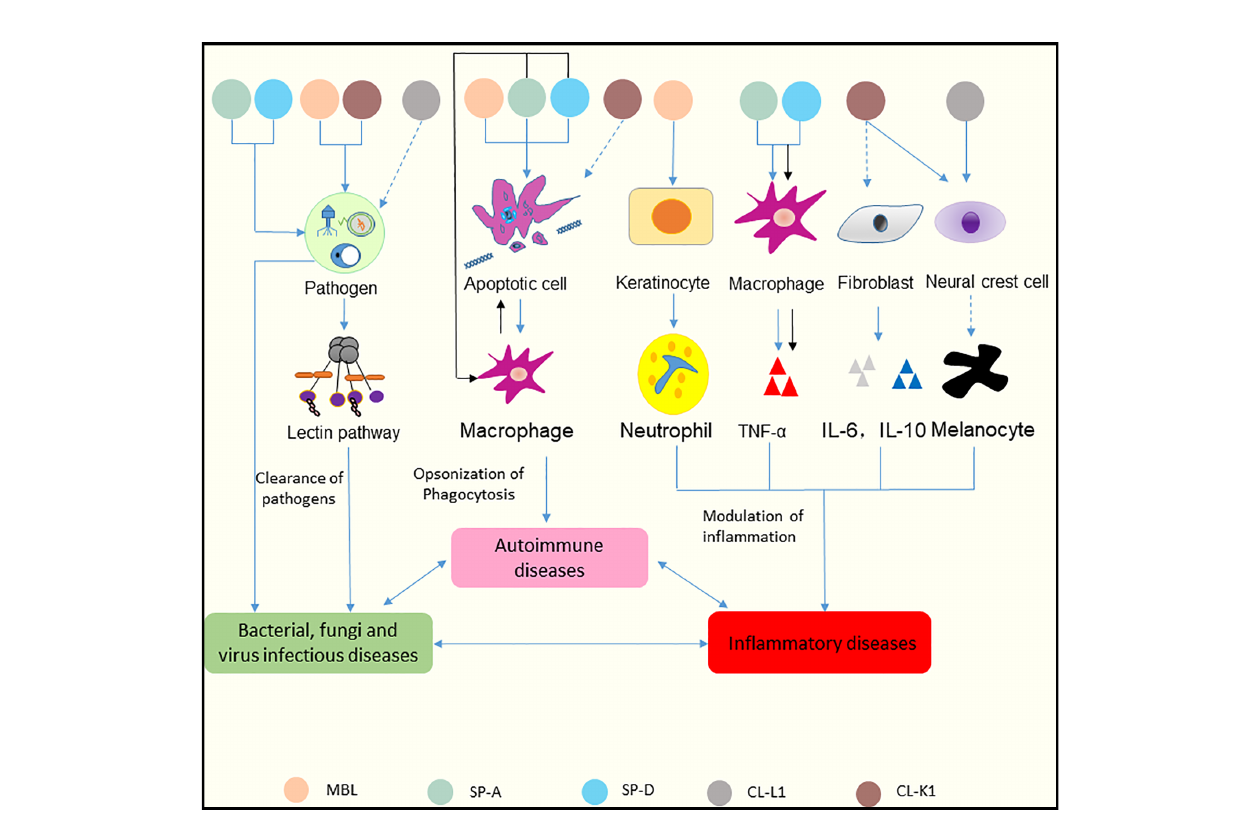
FIGURE 4 | Functions of collectins in skin immune homeostasis. Collectins are similar in structure in terms of their carbohydrate recognition domains, collagen-like, and N-terminal regions. MBL and CL-K1 recognize microorganisms and activate the lectin pathway to clear pathogens. SP-A and SP-D can bind to microorganisms directly and cause aggregation. CL-L1 might initiate the lectin pathway by forming CL-LK with CL-K1. MBL, SP-A, and SP-D can recognize DNA from apoptotic cells and mediate the uptake of apoptotic cells. SP-A and SP-D also suppress apoptotic cell clearance by binding SIRP- a on macrophages (black arrows). MBL promotes keratinocytes to produce chemokine (C-X-C motif) ligand 1 to increase neutrophil in fi ltration. Surfactant proteins might induce the production of TNF- a via macrophages. SP-A and SP-D can bind to SIRP- a on macrophages and epithelia through their globular heads to suppress in fl ammation (black arrows). CL-K1 may modulate the production of IL-6 and IL-10 by fi broblasts. CL-K1 and CL-L1 may in fl uence the function of melanocytes by affecting the immigration of neural crest cells. Clearance of pathogens rely on the participation of in fl ammatory cells and cytokines, and in fl ammatory responses lead to immune cells undergoing apoptosis. In reverse, accumulation of apoptotic cells can cause in fl ammation. And dysfunction of skin caused by in fl ammation results in inability of pathogens clearance. Thus, skin infectious diseases, in fl ammatory diseases and autoimmune diseases interact tightly with each other. The solid lines represent known functions, while dashed lines represent